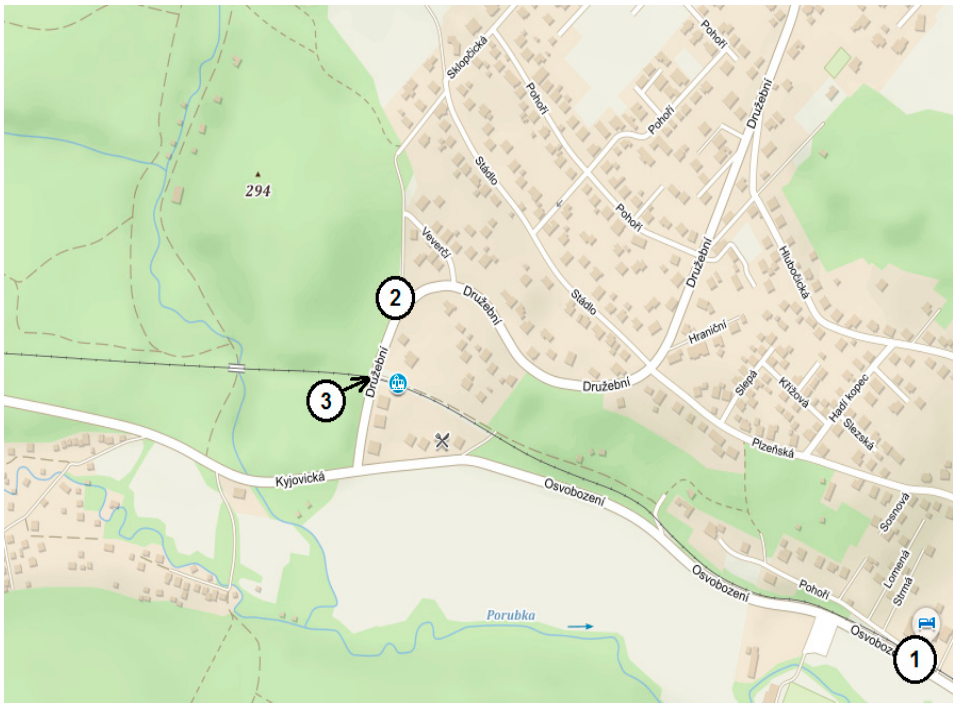
Figure 1. Evaluation route within the Public transport vehicle crossing use-case.